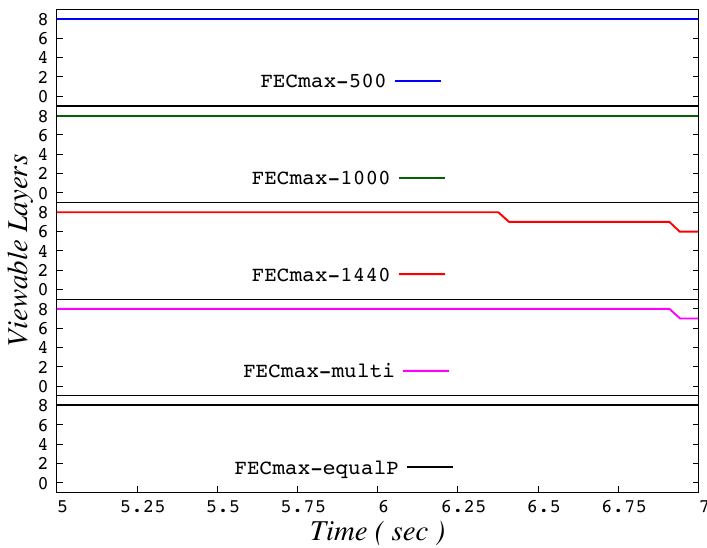
Figure A22. A two-second example of variation in viewable quality for all FEC max models, at a packet loss rate of 10% and a GOP of 16. This illustrates an increase in the FEC max for C1 and C2 based on the worst case scenario, as shown in Table